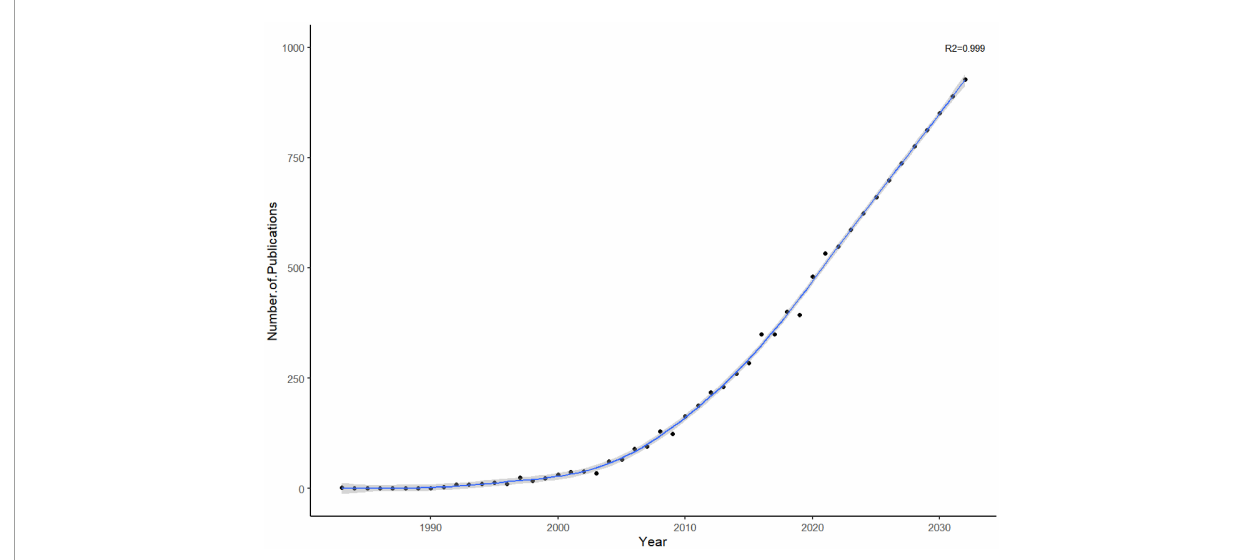
FIGURE2 Trend of publications on MDD-related systematic review/meta-analysis (SR/MA).